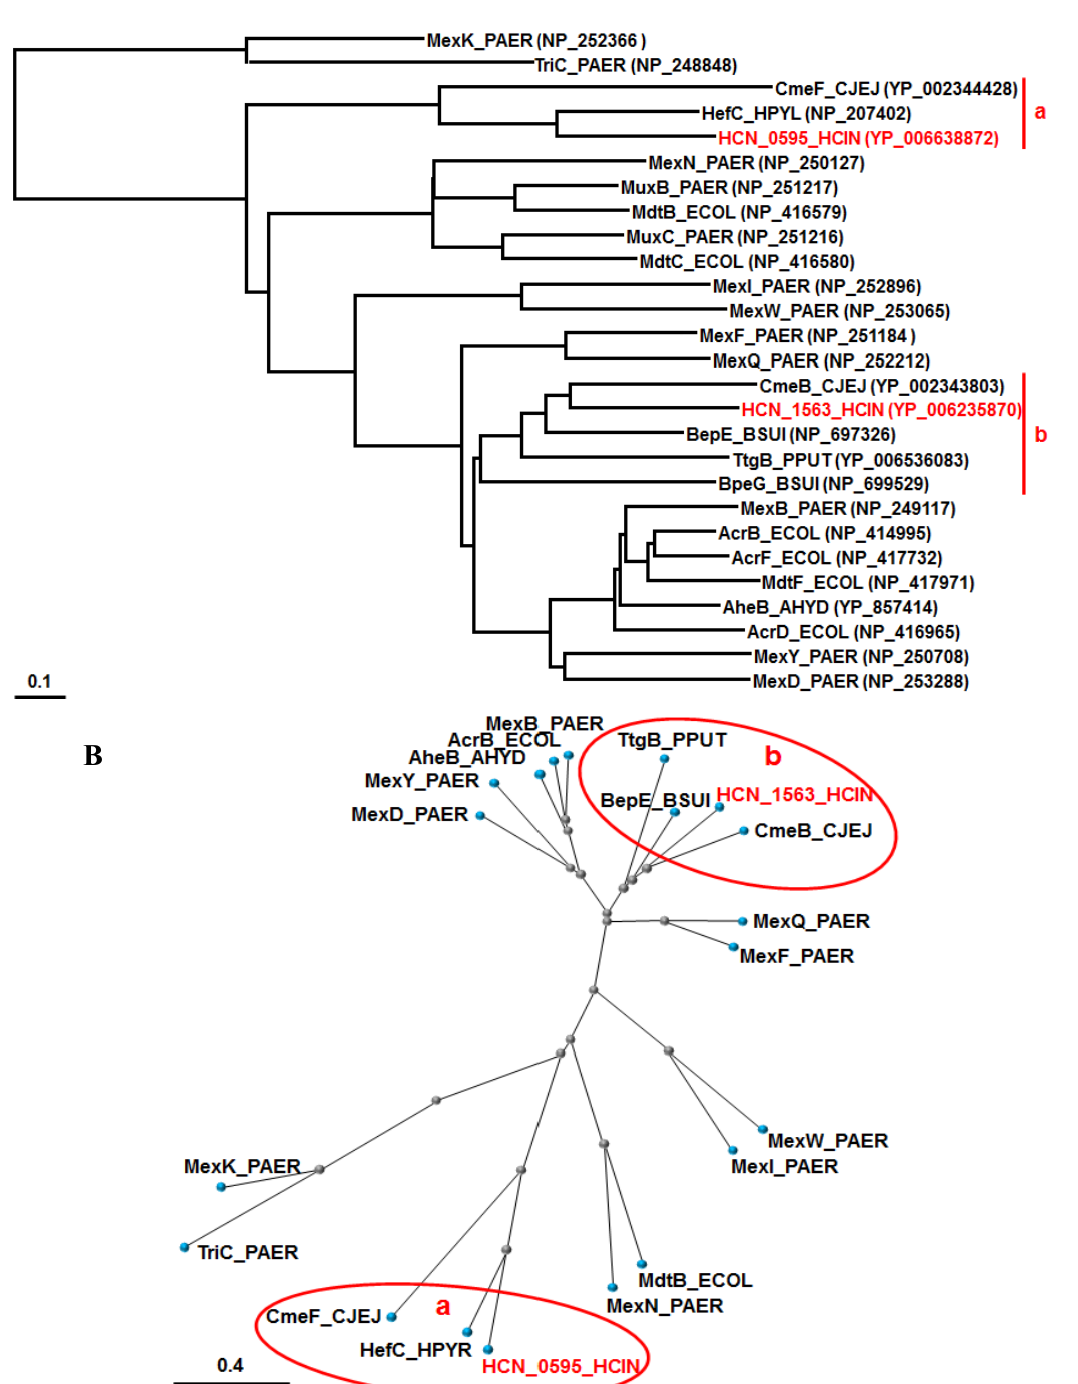
Figure 2. Phylogenetic trees for RND pumps of various bacteria. According to the COBALT program, the trees were constructed using the Fast evolution method and rendered with ( A ) Rectangle and ( B ) Radical. The accession numbers are shown in parentheses. The branches belonging to HCN_0595 and HCN_1563 of H. cinaedi PAGU 611 are shown in red and named “a” and “b”, respectively. The proteins are abbreviated (e.g., “AcrB_ECOL” stands for “AcrB of E. coli ”). Abbreviations; PAER, Pseudomonas aeruginosa ; CJEJ, Campylobacter jejuni ; HPYR, Helicobacter pyroli ; HCIN, Helicobacter cinaedi ; ECOL, Escherichia coli ; BSUI, Brucella suis ; PPUT, Pseudomonas putida ; AHYD, Aeromonas